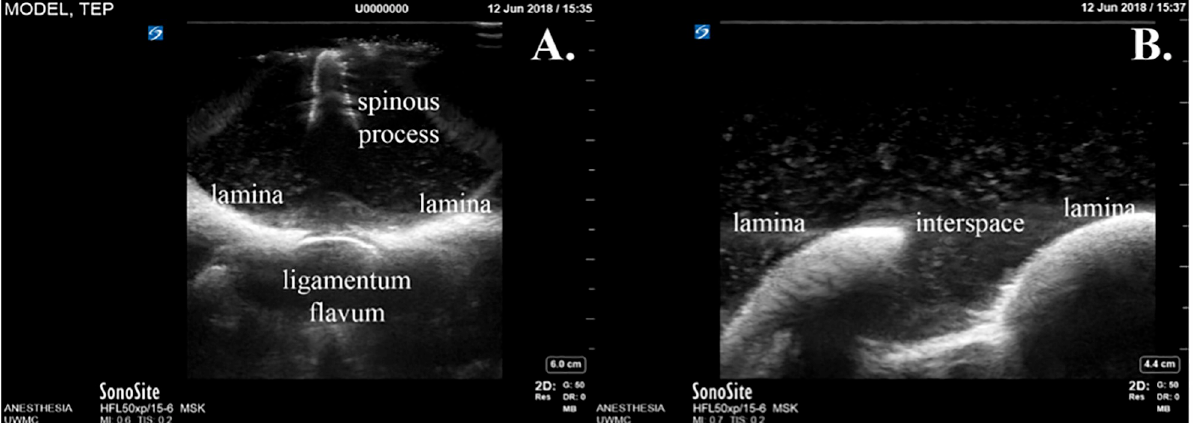
PLOS ONE | https://doi.org/10.1371/journal.pone.0228665 March 11,